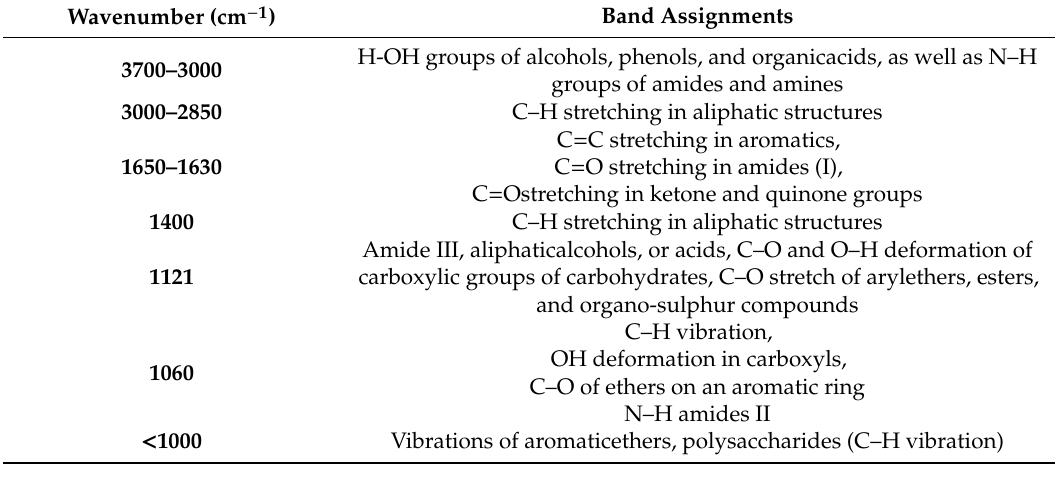
Table 2. Assignments of the main vibrations of the infrared